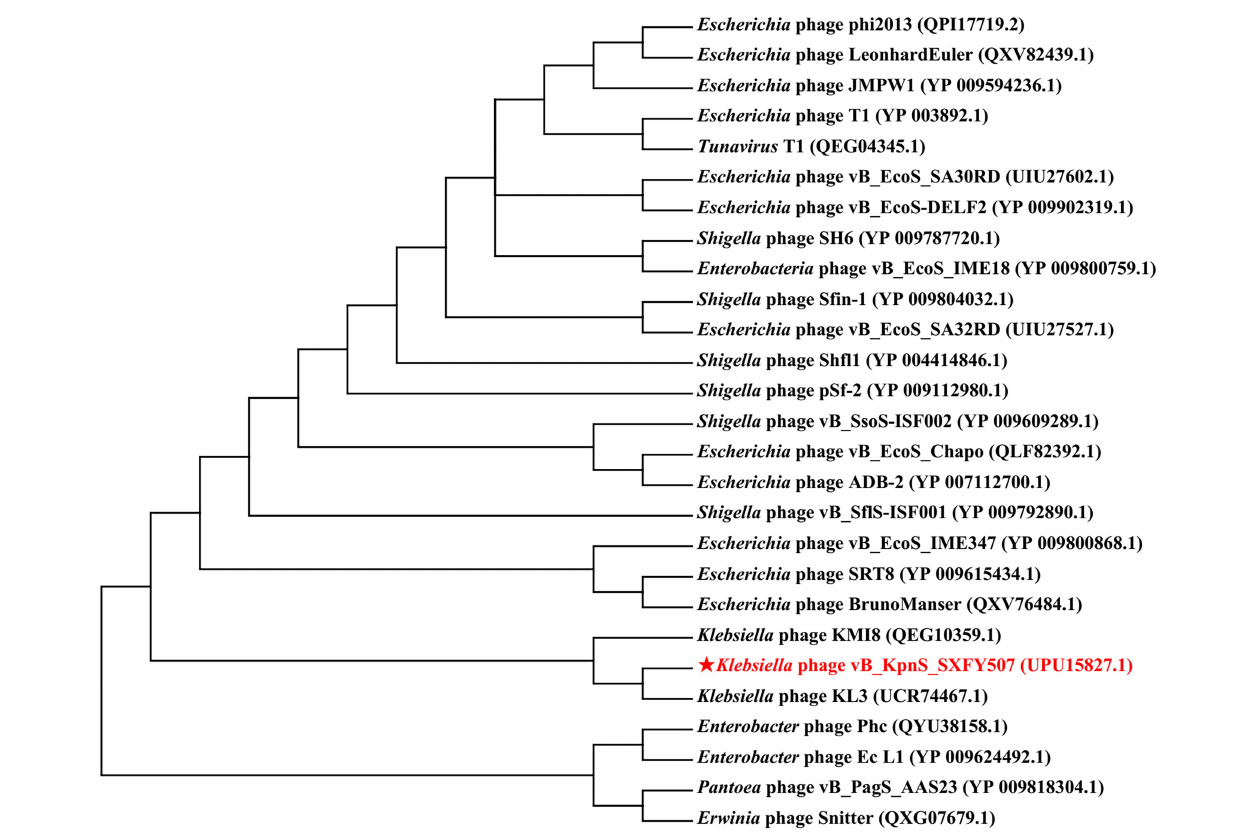
FIGURE 5 Phylogenetic tree constructed based on the terminase large subunit of phage vB_KpnS_SXFY507. The amino acid sequences of the related phages were downloaded from NCBI.